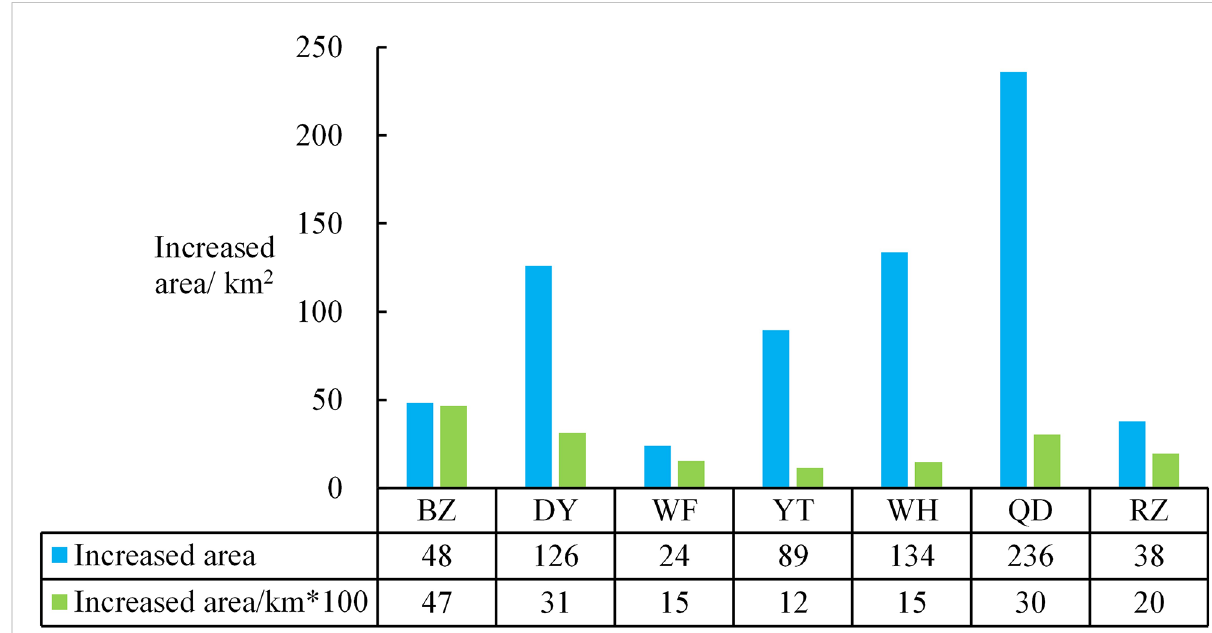
FIGURE 9 Coastal land area changes at the coastal cities of Shandong. BZ, Binzhou; DY, Dongying; WF, Weifang; YT, Yantai; WH, Weihai; QD, Qingdao; and RZ, Rizhao. See the locations of the shorelines in Figure